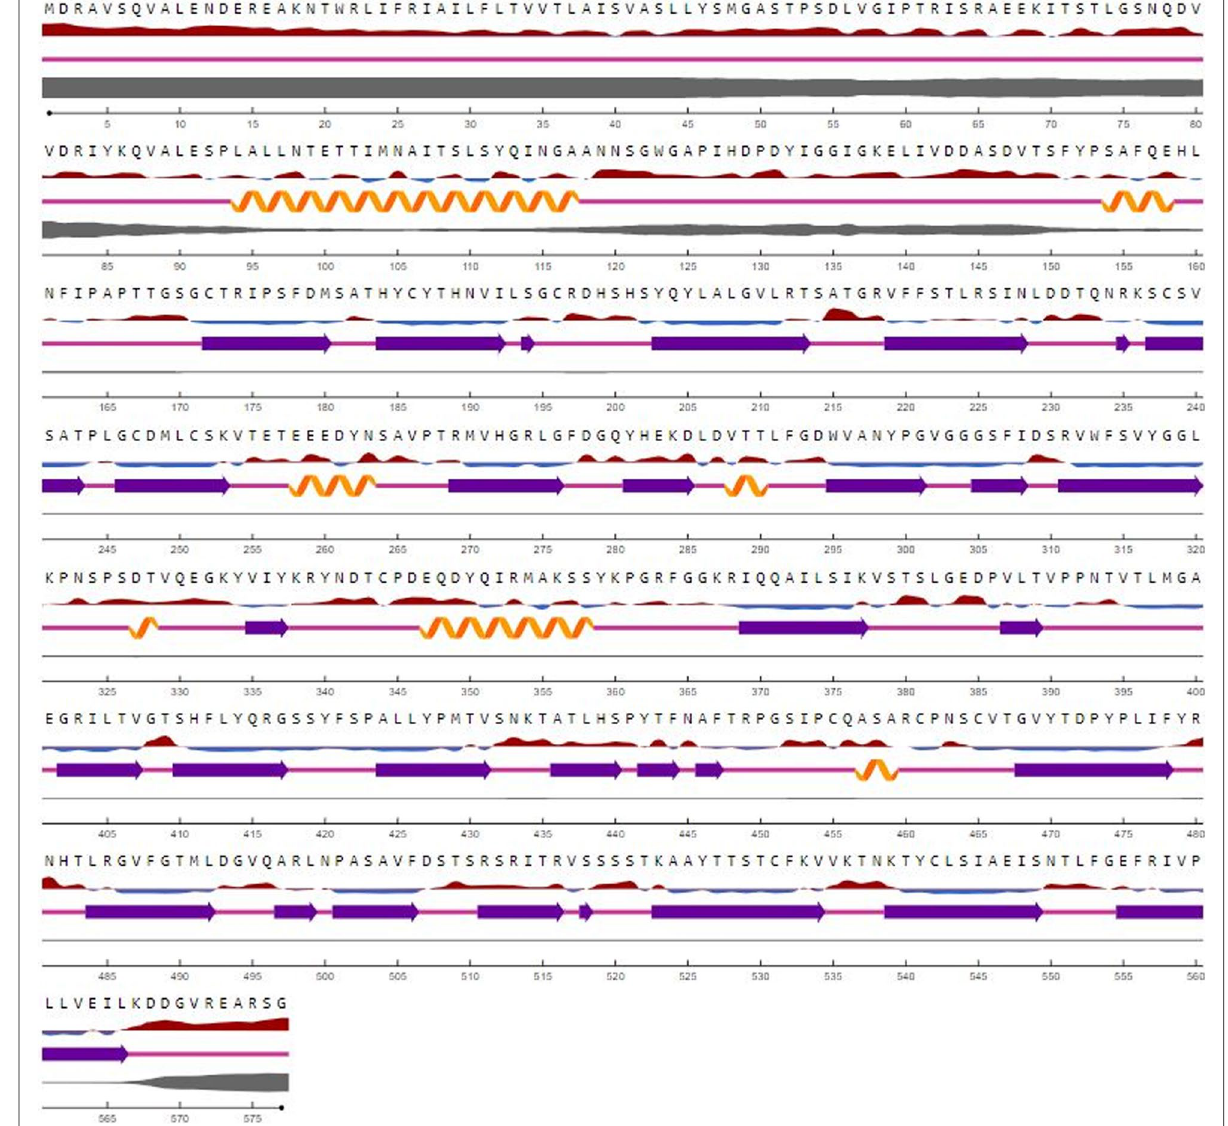
Fig. 3 Deduced amino acid sequence and the secondary structure of the HN protein. The helices are shown by a yellow colour, the strands are represented as purple arrows and the coils are represented as pink